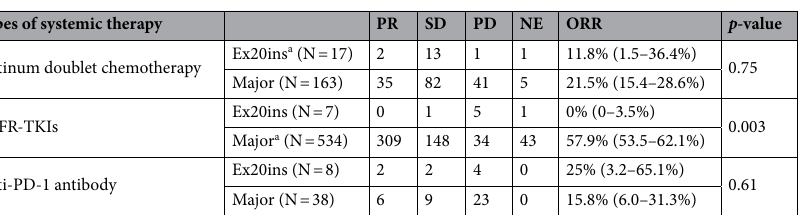
Table 2. Response of systemic therapy in patients with EGFR exon 20 insertions and major mutations. PR partial response, SD stable disease, PD progressive disease, NE non-evaluable, EGFR-TKI epidermal growth factor receptor-tyrosine kinase inhibitor, Ex 20ins exon 20 insertions, PD-1 programmed cell death-1. a First- line